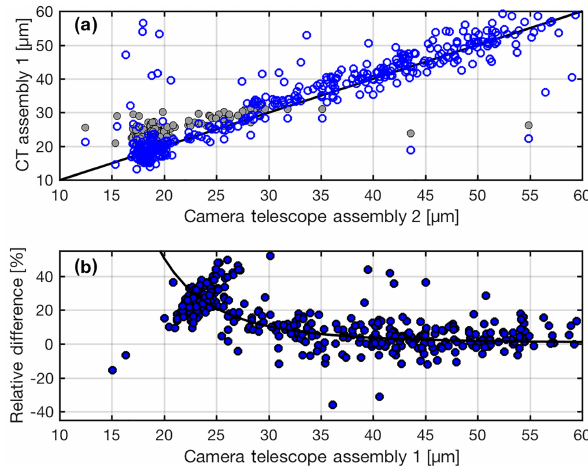
Figure 7. Example of an oversize correction for small particles and a low magnification setting of 4 × in camera telescope (CT) assem- bly 1. CT assembly 2 was set to 6 × magnification. For cloud par- ticle sizes smaller than 30µm, the image analysis algorithm applied to the CT assembly 1 images starts to oversize the particles due to enhanced image blur (gray symbols in a ). An oversizing in the range between 10 and 50% is observed (blue symbols in b ). By using the sizing results for CT assembly 2, a correction function can be de- duced to empirically describe this oversizing (black line in b ) and to correct the sizes deduced for CT assembly 1 (blue symbols in a